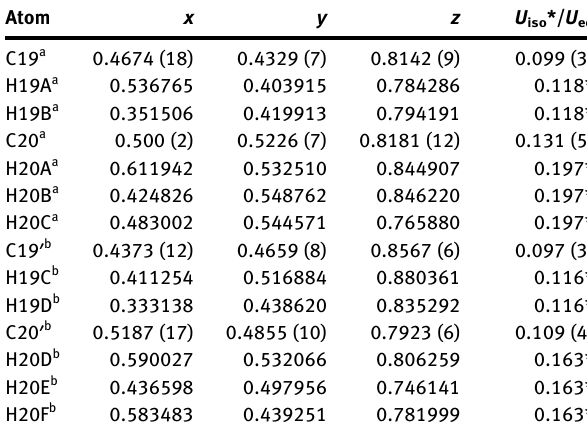
the synthesis of new functionalized imidazole-based Ni complexes is highly desirable [6, 7]. For example, Cetin- kaya and the coworker described the synthesis and crystal structures of three new cyano-bridged tetracyanonickelate(II) complexes with 1-ethylimidazole ligand [8]. Lately, Dou et al. [9] reported the 1-ethylimidazole-based Ni-polyoxovanadates